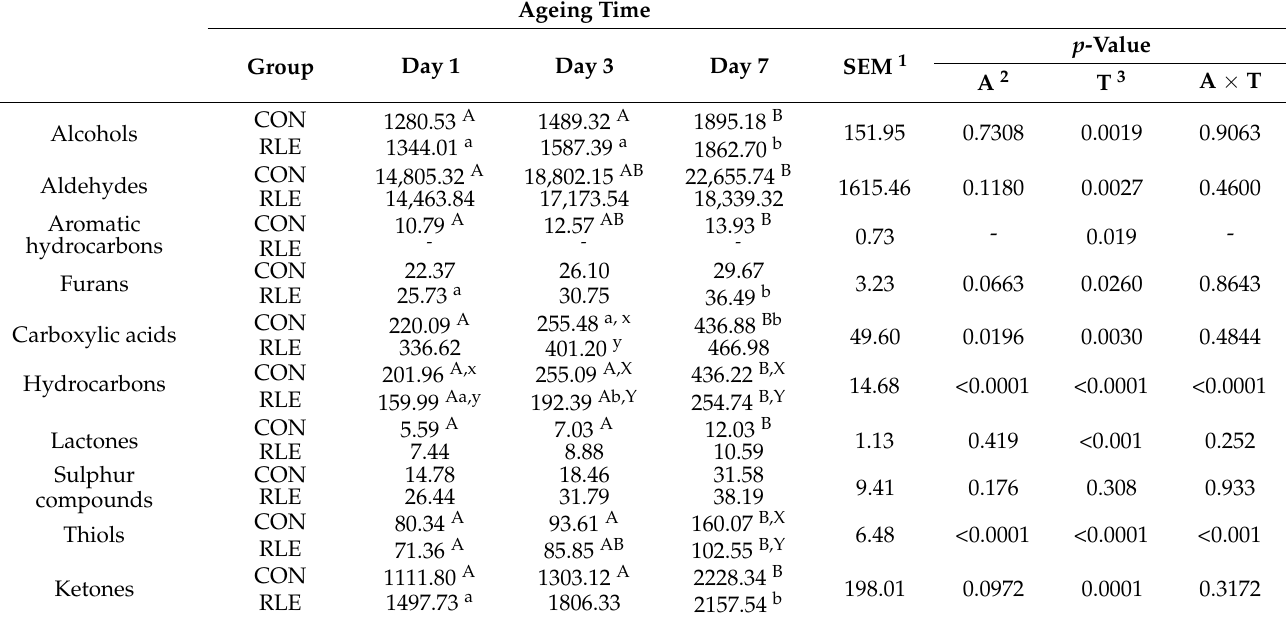
Table 2. Effects of anthocyanin diet addition and ageing on volatile organic compounds of meat from goat kids ( n = 30 samples for each experimental group). Results are expressed as ng/g of